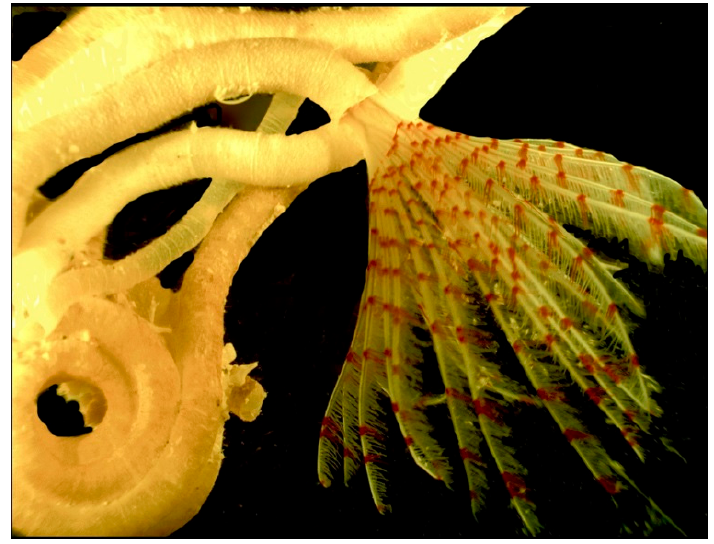
Figure 11. A newly described serpulid worm Turbocavus secretus.